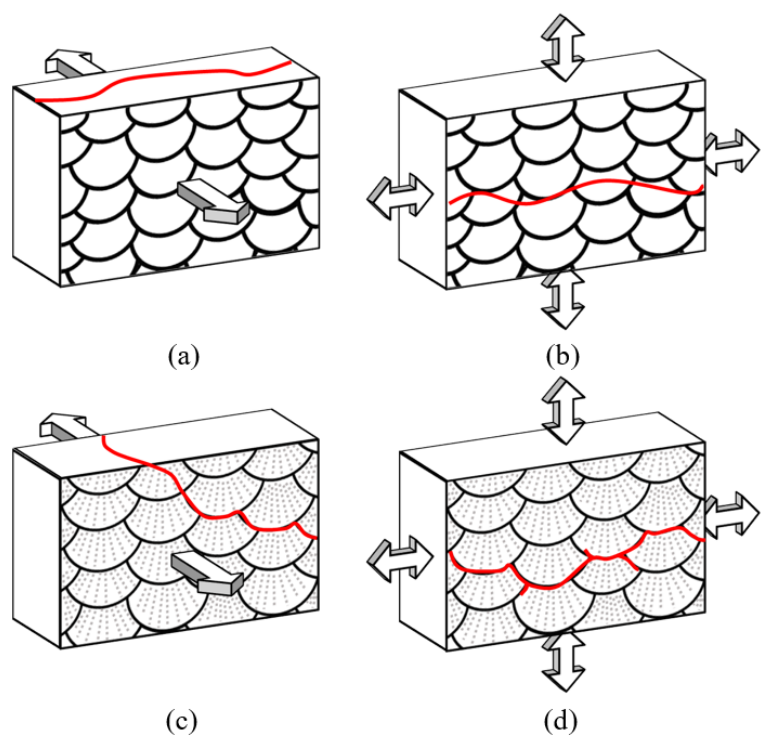
Figure 12. Schematic of the force direction and texture effect before and after heat treatment: ( a ) tensile failure of As-printed, ( b ) fatigue failure of As-printed, ( c ) tensile failure of heat-treated, and ( d ) fatigue failure of heat-treated.